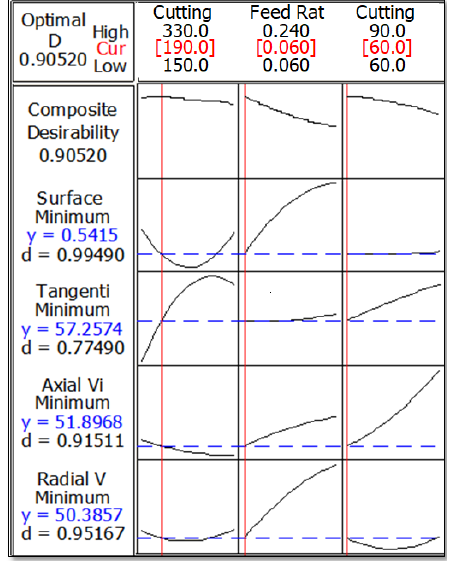
Figure 7. Optimum cutting conditions for minimum surface roughness and vibration.